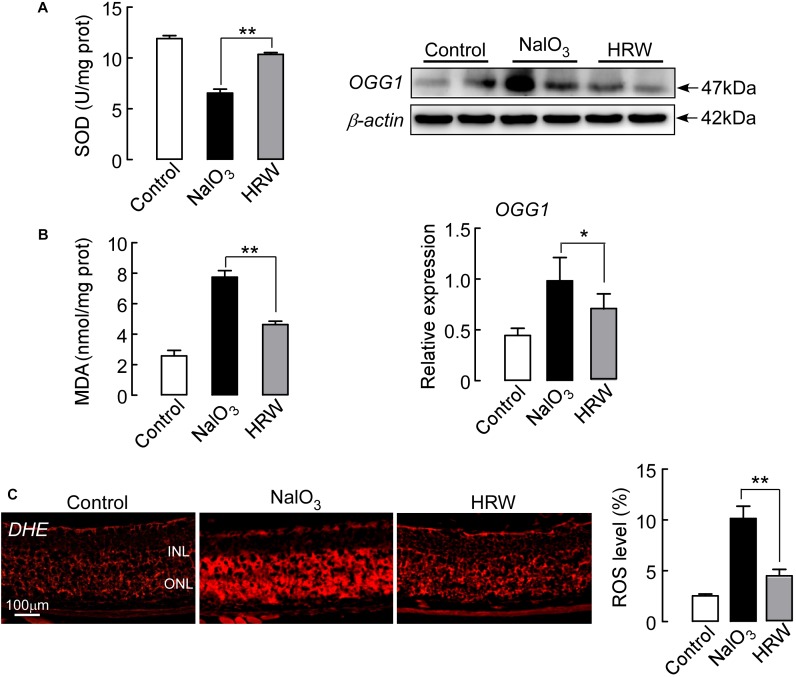
Effect of HRW on NaIO3-exerted retinal oxidative stress in mice. Retinal tissue collection after cotreatment with HRW and NaIO3 for 12 days. (A) The level of SOD and MDA in the retina was analyzed by SOD and MDA kits. (B) Representative blots and densitometry data of OGG1 expression in the retinas from NaIO3 mice with and without HRW treatment. (C) The activity of ROS was measured by DHE staining, the red staining is positive for ROS content. Data represent the mean ± SEM of three independent experiments, n = 3, ∗P < 0.05, ∗∗P < 0.01 vs. the NaIO3 group.